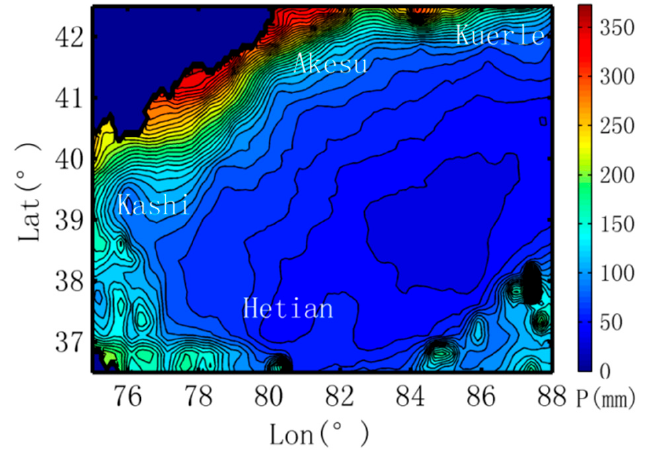
Figure 2. Spatial distribution of annual precipitation in Tarim Basin based on The China Meteorological Forcing Dataset.